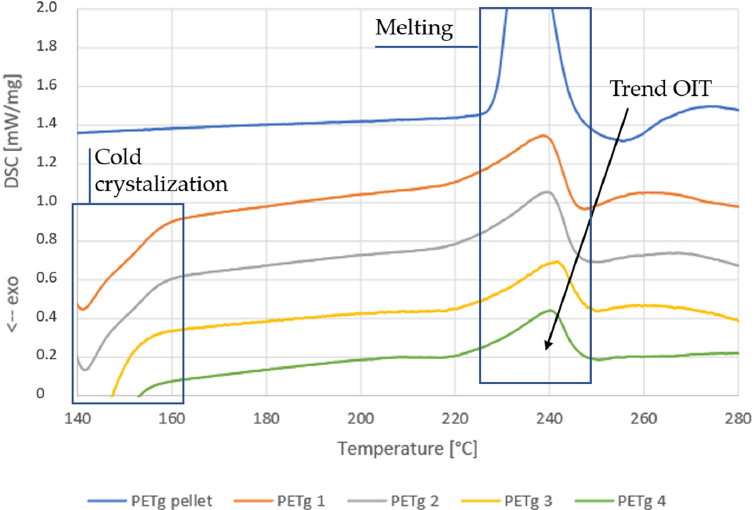
Figure 6. DSC curves of the STA analyses of the PETg residence time samples, extruded with the HAAKE Minilab twin-screw extruder, for the determination of the oxidation initiation temperature. To obtain an idea of the thermal stability of the polymer samples, the temperatures at which the residual mass of the sample is 95% of the initial mass are depicted in Figure 7. For PETM, the sample lost 5% of its mass between 359 °C and 372 °C, and PETg lost 5% between 343 °C and 356 °C.